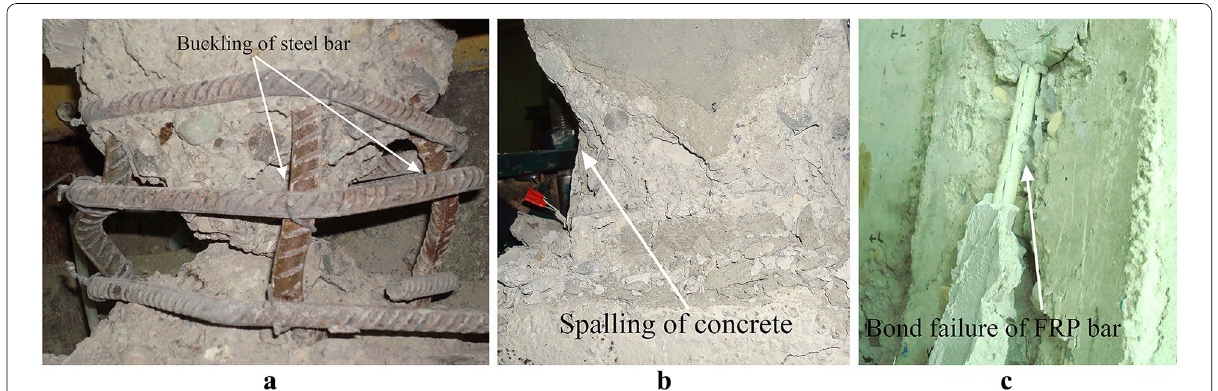
Fig. 4 Typical failure mode of specimens: a buckling of steel reinforcement; b spalling of concrete; c bond failure of GFRP